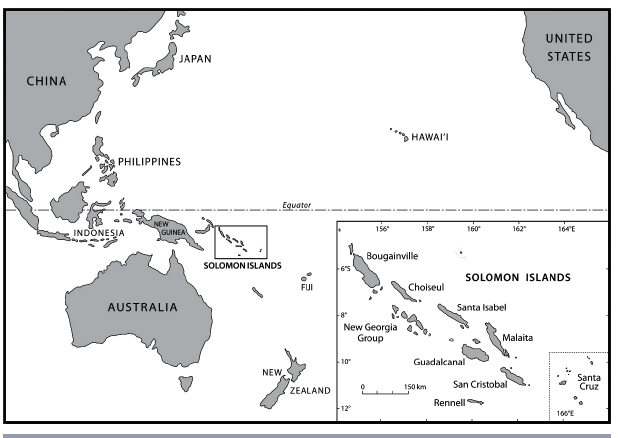
Fig. 1 . Map of the Pacific showing the location of the Solomon Islands and key areas mentioned in the text.